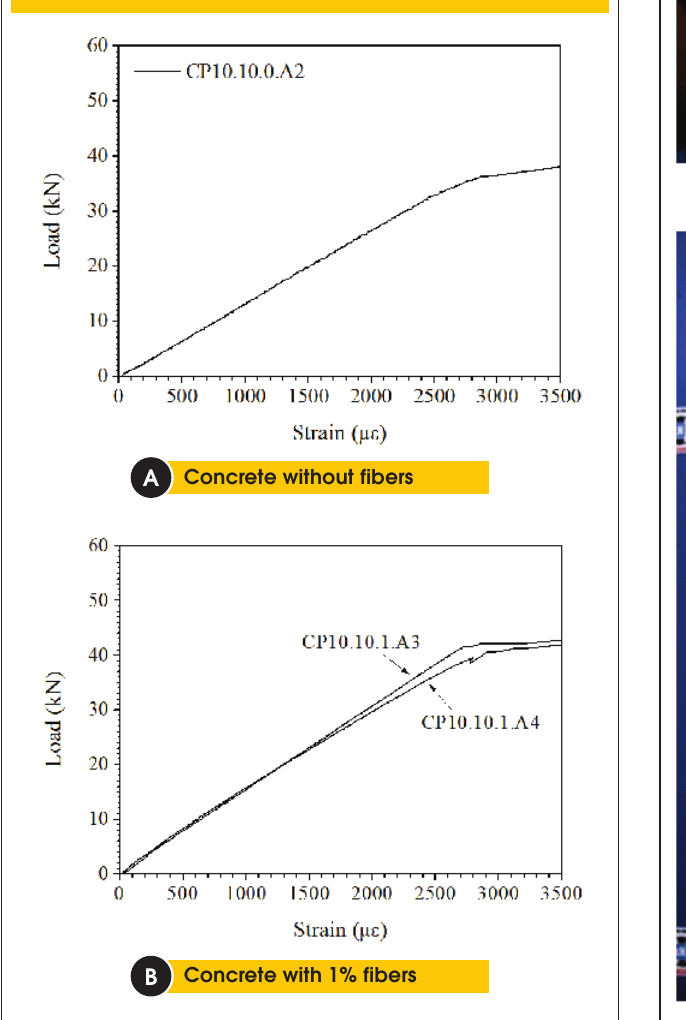
Figure 6 – Load versus bar strain for test specimens with bar of 10 mm diameter and anchorage equal to 10